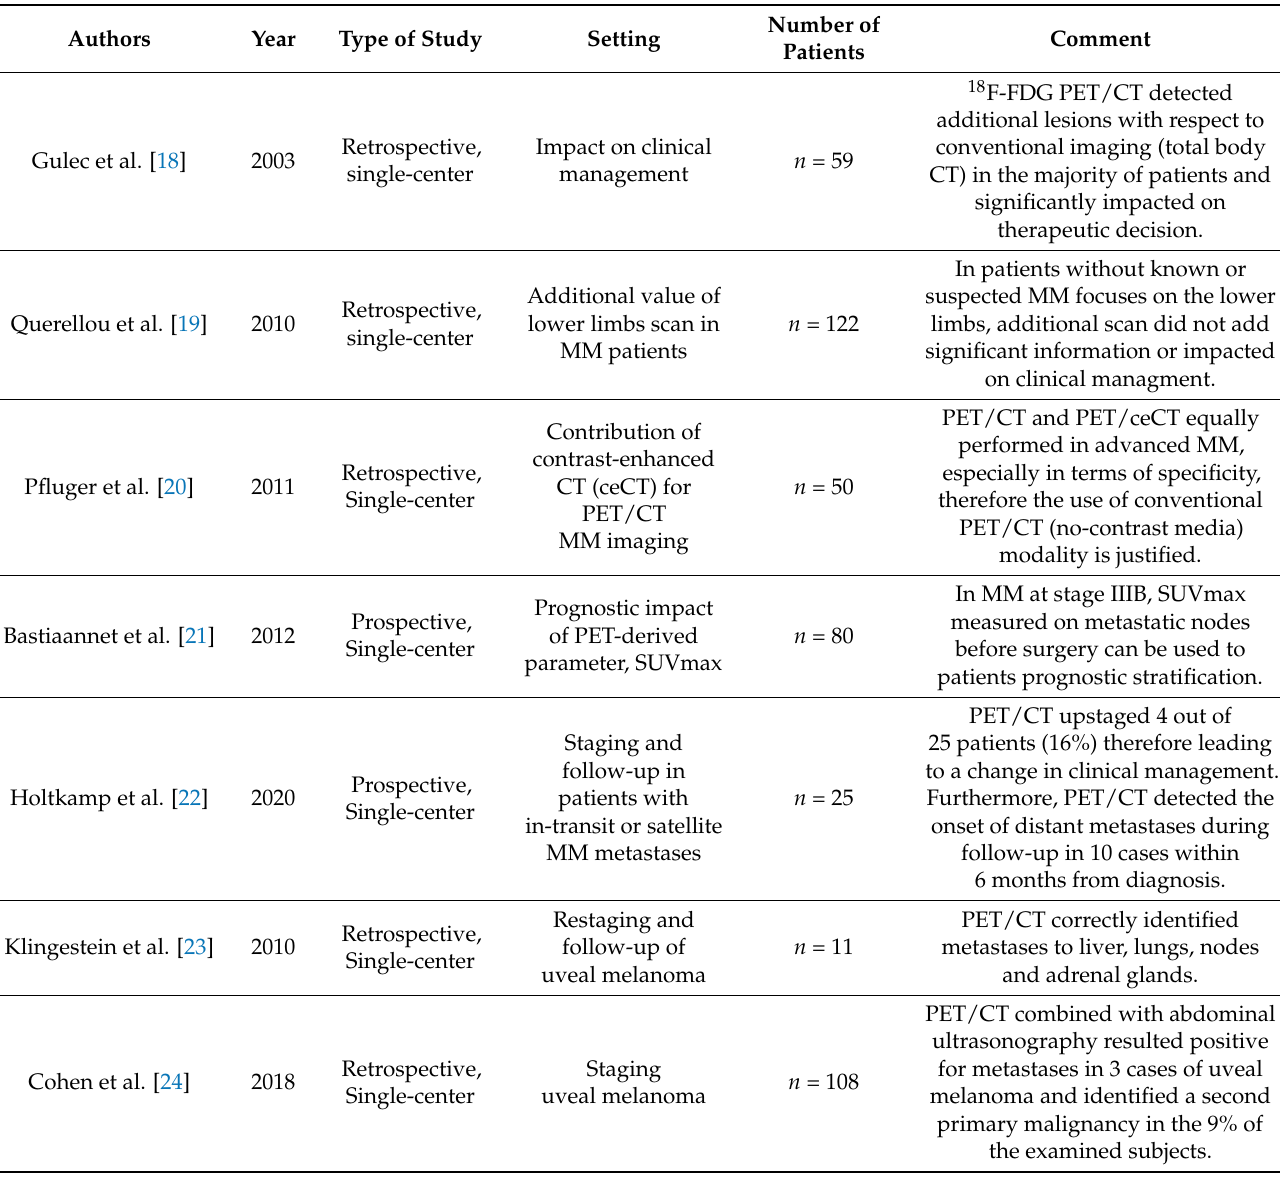
Table 1. Summary of main manuscripts focused on the role of 18 F-FDG PET/CT for the imaging of advanced